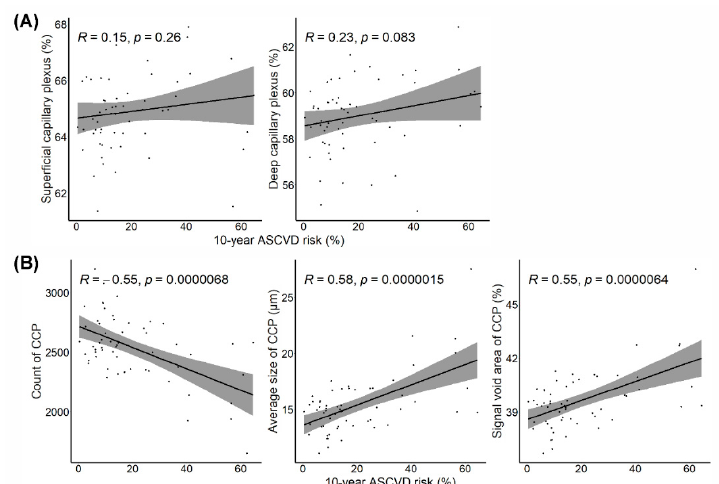
Figure 4. The association between the 10-year atherosclerotic cardiovascular risk and optical coher- ence tomography angiography parameters, including ( A ) retinal vessel density of the superficial capillary plexus and deep capillary plexus, and ( B ) choriocapillaris flow void features. CCP, chori- ocapillaris; ASCVD, atherosclerotic cardiovascular disease.